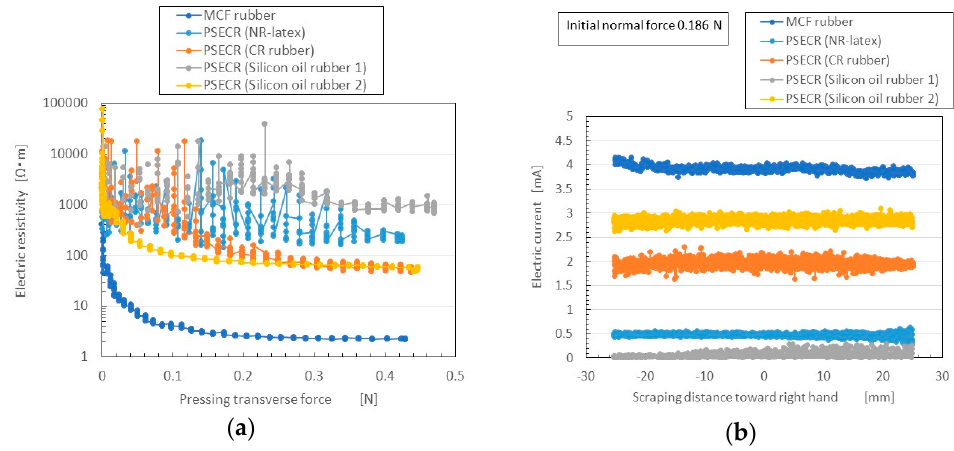
Figure A1. Electric characteristics of other PSECRs compared with that of the MCF rubber made by the present new method: ( a ) in the case of NFE; ( b ) in the case of SFE.